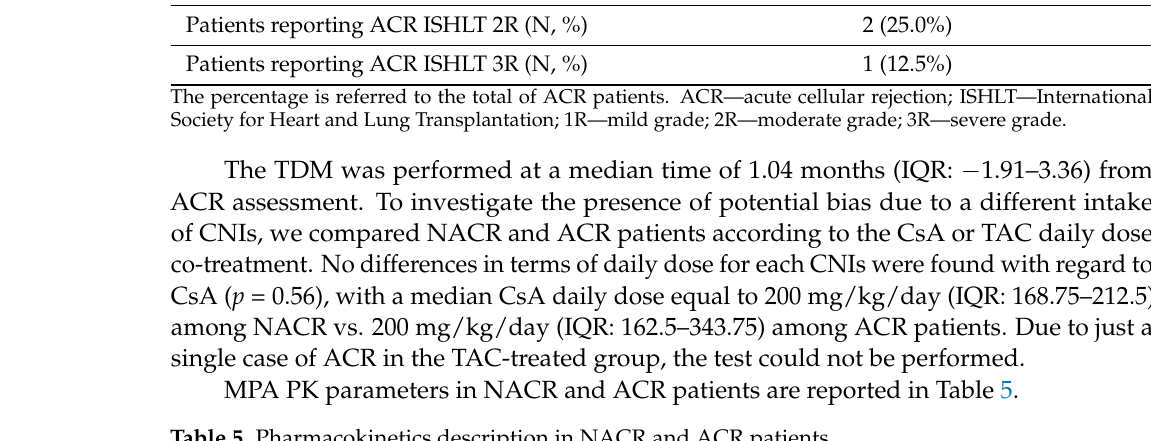
Table 5. Pharmacokinetics description in NACR and ACR